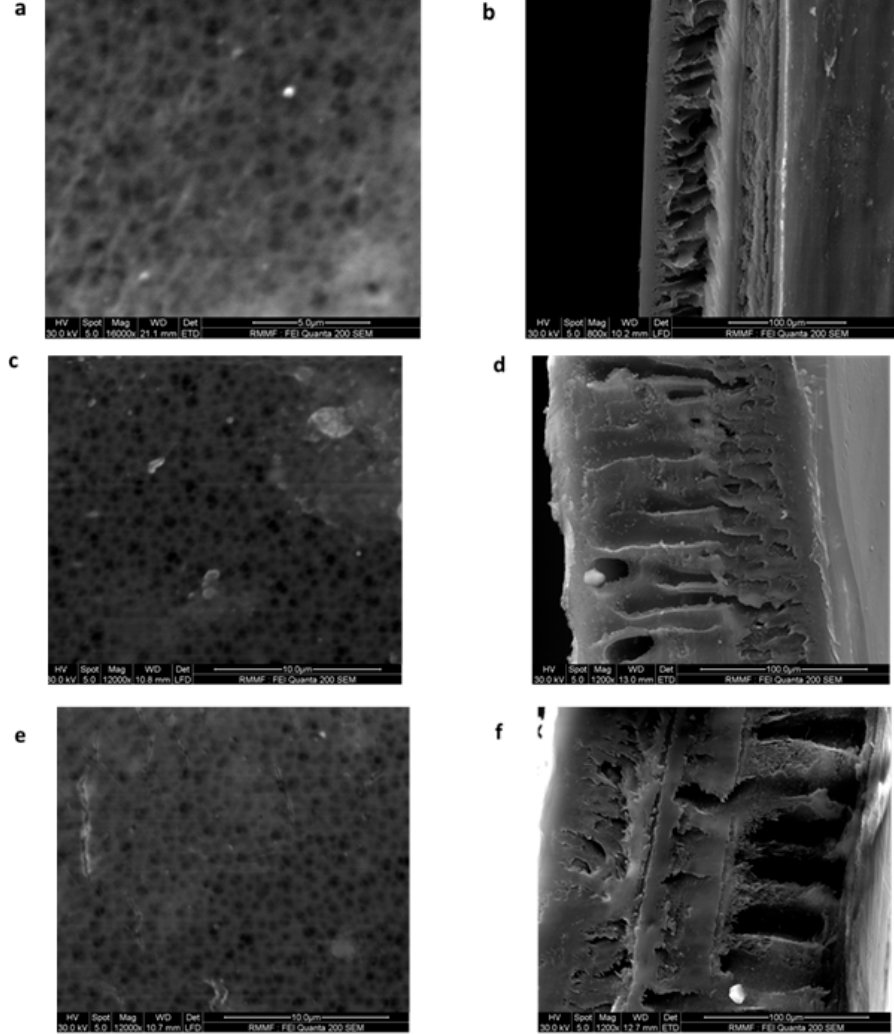
Figure 6. Environmental Scanning Electron Microscopy (ESEM) images of surface (( a )—mag 16,000 × , ( c )—mag 12,000 × and ( e )—mag 12,000 × ) and cross sections (( b )—800 × , ( d )—1200 × and ( f )—1200 × ) of membranes having compositions 15 wt % PSf ( a , b ), 15 wt % PSf–0.25 wt % GO ( c , d ), and 15 wt % PSf– 1 wt % GO ( e , f ), respectively.